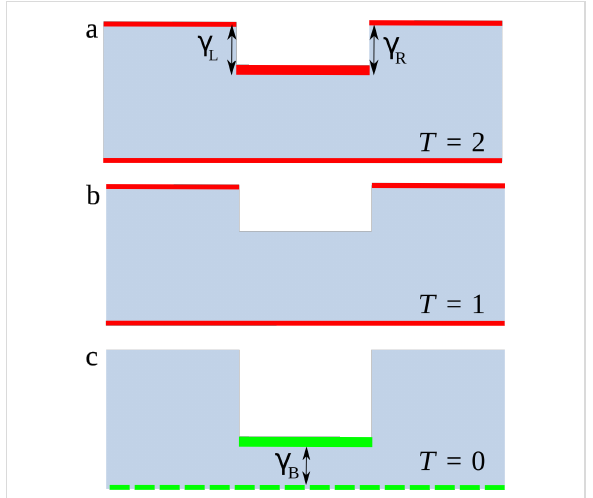
Figure 6: Schematic representation of the main transmission-probabili- ty conditions. The grey areas represent the nanoribbons with constric- tions, with different edge-state behaviors highlighted by red and green lines. (a) Resonant transmission at the upper edge summed up to the continuous transmission at the lower edge, hence T = 2. The resonant coupling of the confined state at the constriction with the left(right) con- tact is represented by γ L ( γ R ). (b) Off-resonance negligible transmis- sion at the upper edge with the continuous transmission at the lower edge, T = 1. (c) Anti-resonance in the transmission due to the strong coupling, represented by Γ B , between the confined state at the deep constriction and the lower edge, now depicted as a dashed line indicat- ing the absence of transmission, T = 0.